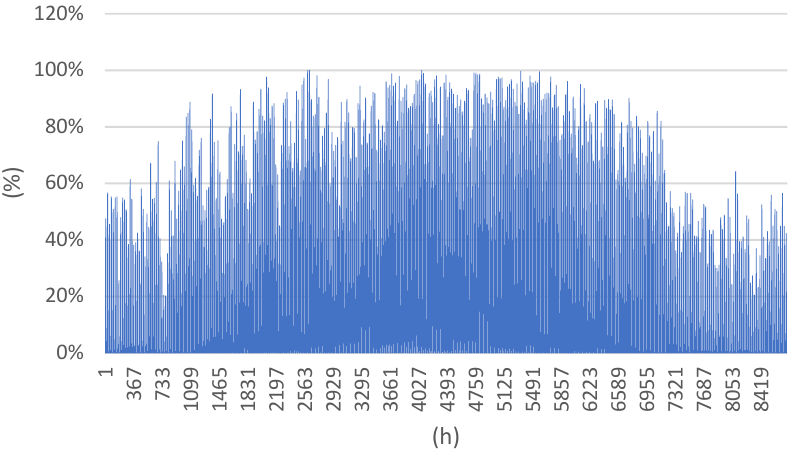
Figure 11. Solar power plant utilisation.